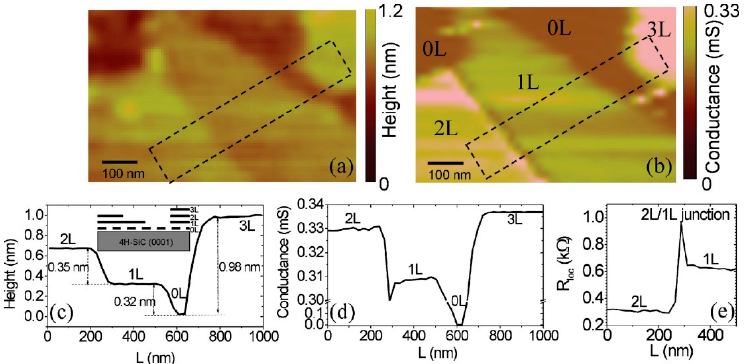
Figure 25. ( a ) AFM morphology and ( b ) conductance map on an epitaxial graphene with lateral variations in the number of layers. ( c ) Height profile extracted from the selected area on the morphology map, with the layer structure schematically represented in the insert. ( d ) Conductance profile extracted from the selected area in the conductance map. ( e ) Local sheet resistance of graphene calculated from the conductance profile in the region close to the monolayer/bilayer junction [127].